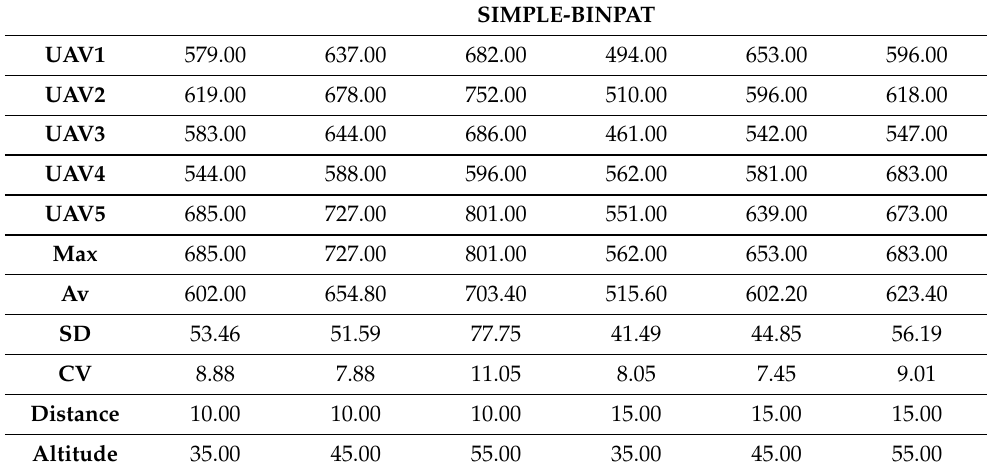
Table A10. Time results using the SIMPLE-BINPAT algorithm and five UAVs in a long-track scenario.